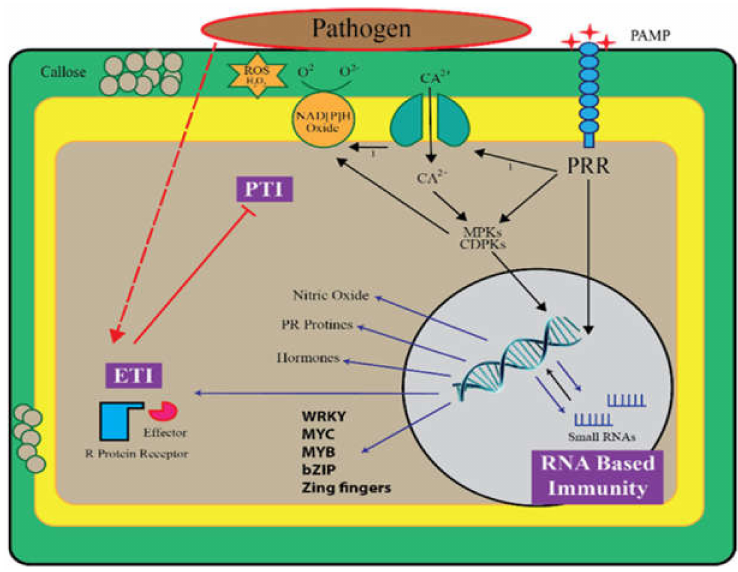
Figure 1. A mechanism for protecting plants against fungal and bacterial pathogens. Typical responses to basal pathogen-triggered immunity and pathogen-specific effector-triggered immunity and the RNA-based immune system are presented. PTI, pattern-triggered immunity; ETI, effector- triggered immunity; PR, pathogenesis-related; PRR, pattern recognition receptor; PAMP, pathogen- activated molecular pattern; CDPKs, calcium-dependent protein kinases; ROS, reactive oxygen species; MPKs, mitogen-activated protein